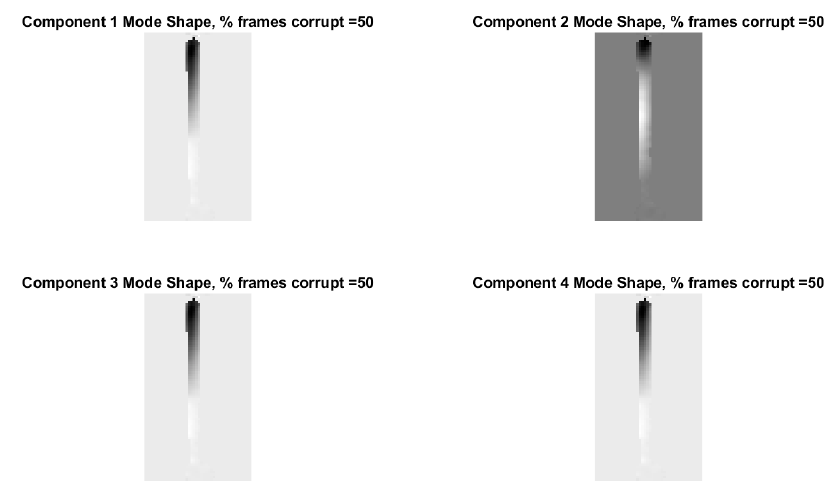
Figure 25. Mode shapes recovered when 50% of the frames and randomly removed and the frames are randomly shuffled in temporal order.